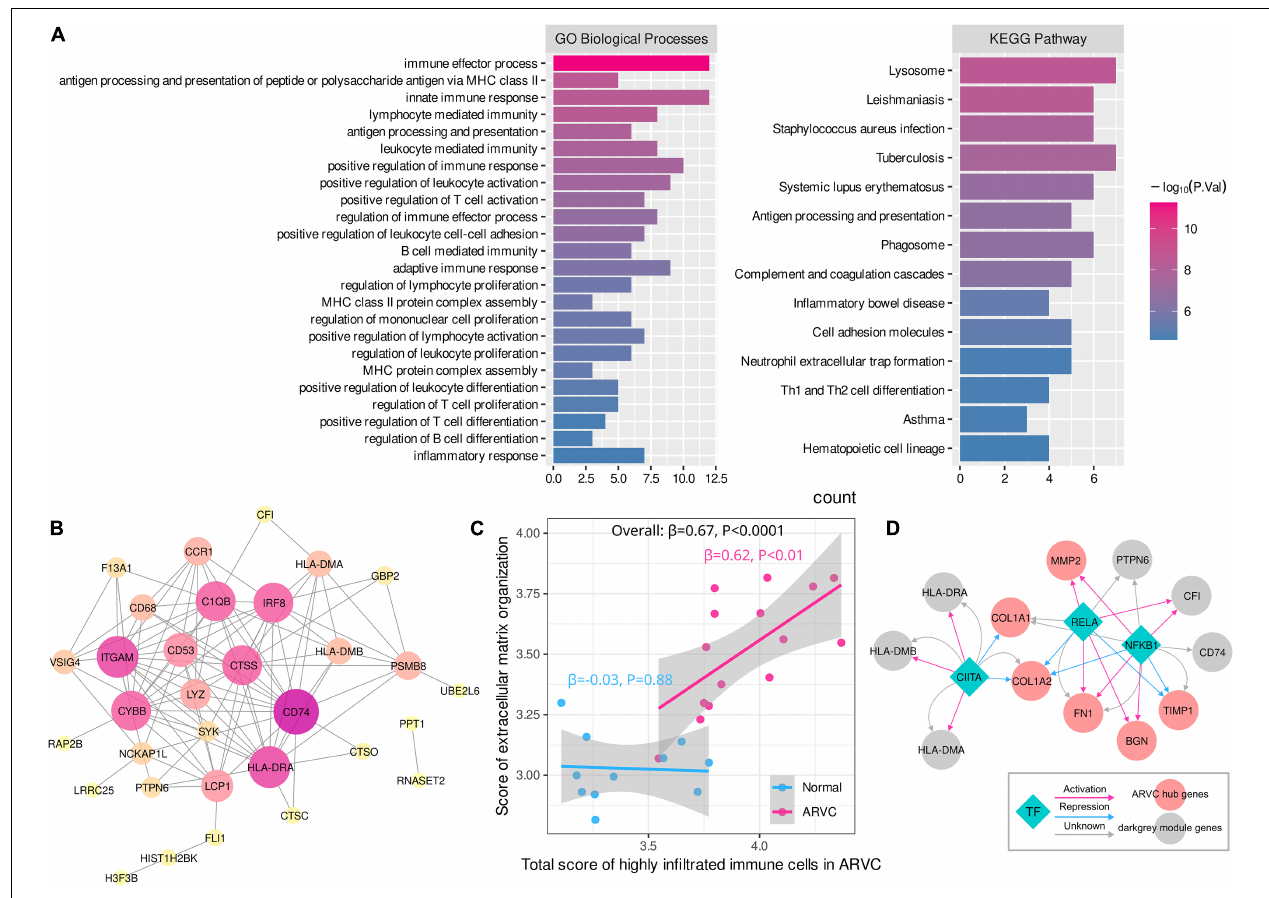
FIGURE 5 | Functional enrichment and PPI network of the immune-related module and the relationship between myocardial fibrosis and immune cell infiltration. (A) Functional enrichment of genes in darkgrey module. (B) PPI network of genes in darkgrey module, larger node sizes represent higher connection degrees within the network (disconnected nodes were concealed). (C) The linear correlation analysis between the score of extracellular matrix organization and the total score of the highly infiltrated immune cells. (D) Shared transcription regulators (TFs) of ARVC hub genes and darkgrey-module genes. MHC, class II major histocompatibility complex; Th1, type 1 T helper cell; Th2, type 2 T helper